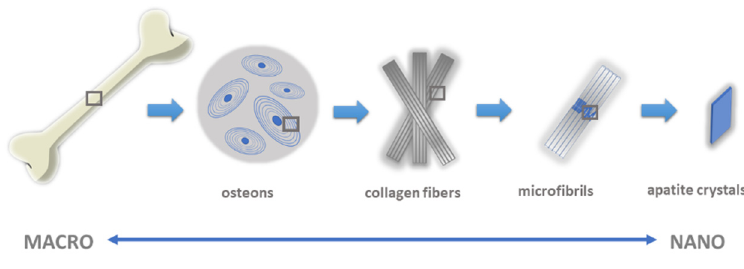
Figure 1. The multi-scale structure of natural